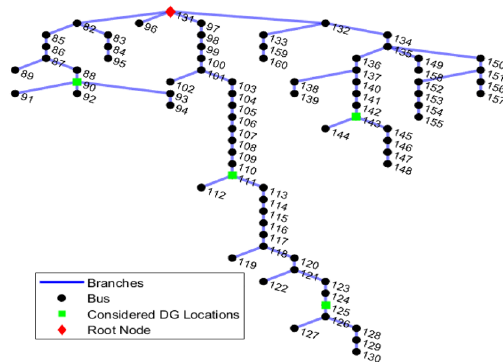
Fig. 3 Layout of considered section of Tanzanian power distribution